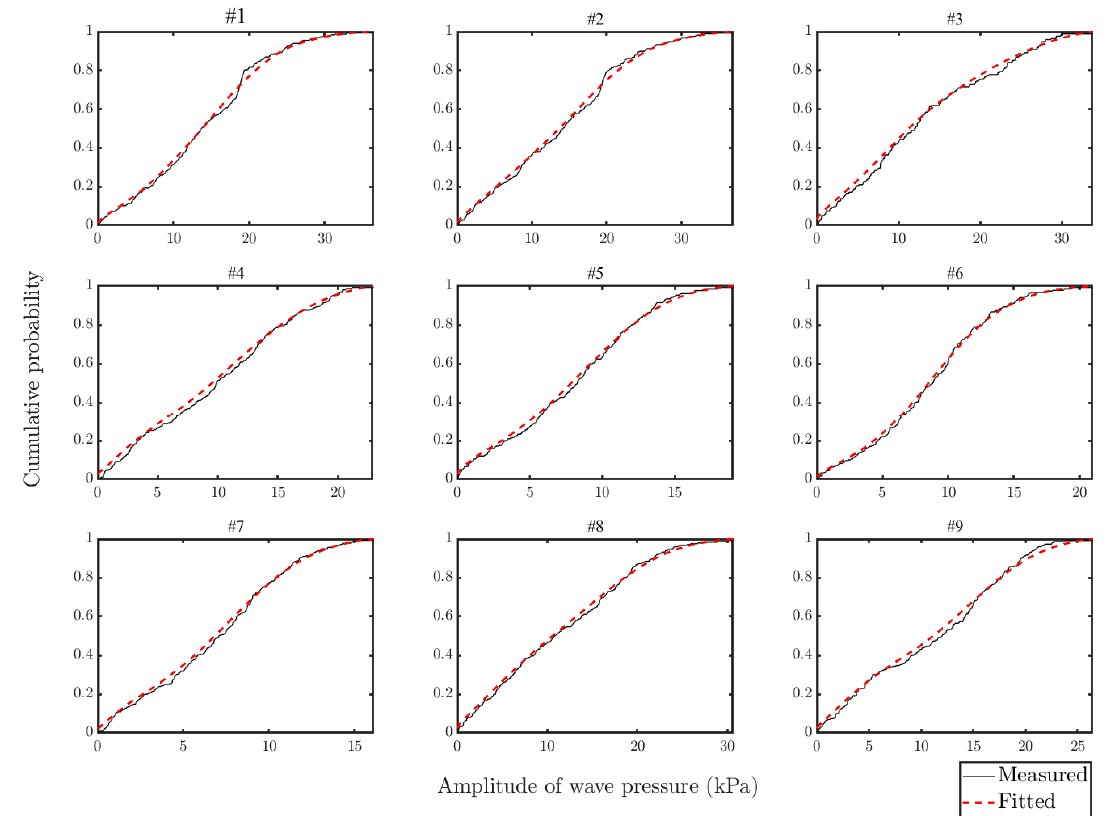
Figure 9. CDFs of the measured wave pressure amplitude at − 2.37 m.